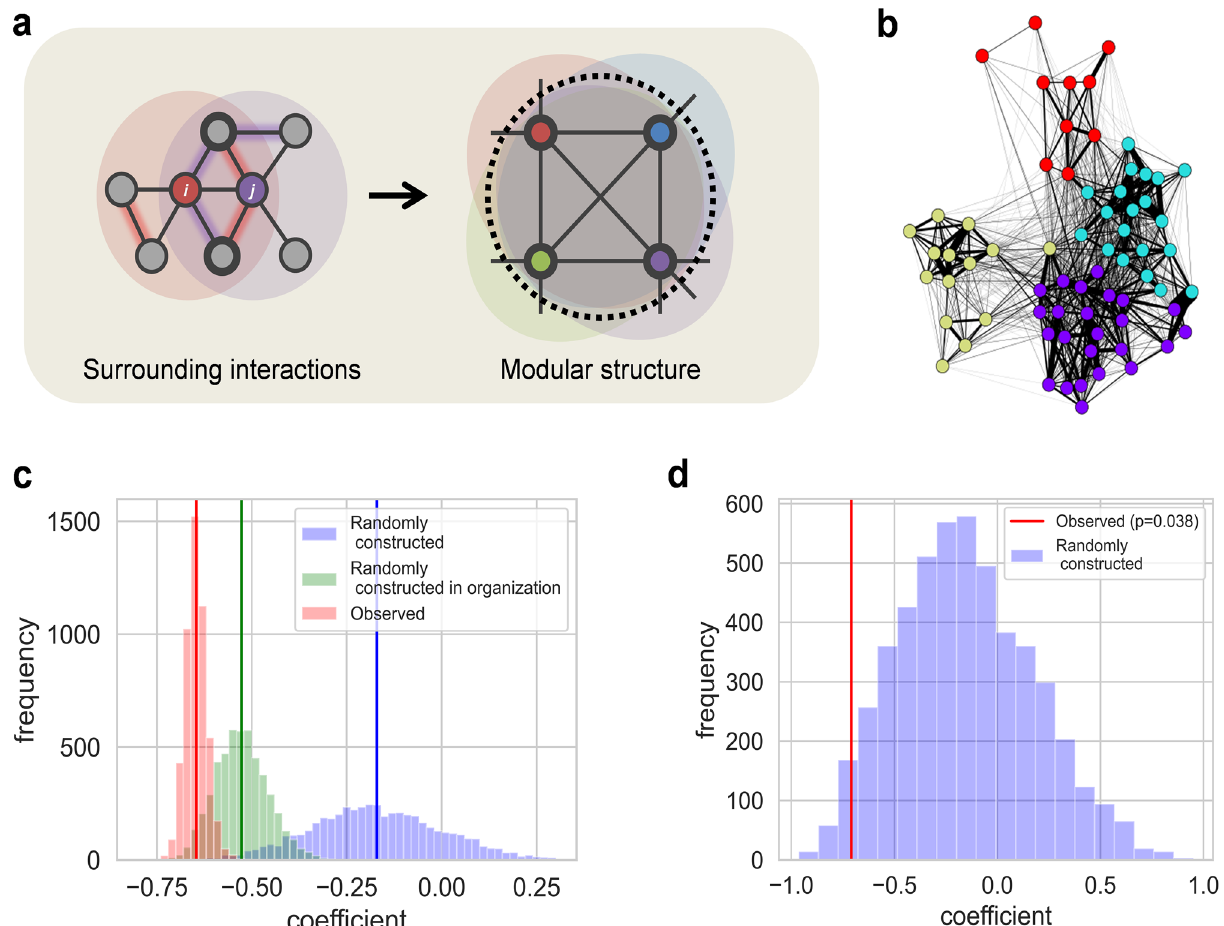
Figure 3. Modular group structure of the face-to-face interaction network and the relationship between Clustering w(B) and depression score in the group unit. ( a ) (Left) Surrounding interaction overlaps by the number of neighbours (bold lines) shared with neighbouring nodes. (Right) In a modular network structure, since each node’s surroundings overlap at a high rate within the structure, this structural unit significantly influences the clustering of the nodes belonging to it. ( b ) A representative visualization of the face-to-face interaction network of one workplace. The width of the link indicates the frequency of interaction, and the colour of the node indicates the community constructed by the community detection algorithm. Modular community structures are observed where frequent interactions occur internally. ( c ) The distributions of the Spearman correlation coefficient between the average Clustering w(B) and the average depression score of each community are shown. Each distribution represents the correlation coefficient of the community structures observed by the community detection algorithm (Red), randomly constructed (Blue), and randomly constructed within each organization (Green). Since the Louvain algorithm 36 used for community detection led to some variation in the results depending on the order of randomization in the extraction process, the coefficients in the observed community are also represented as a distribution. Each distribution was constructed through 5000 random sampling results. ( d ) The Spearman correlation coefficients between the average Clustering w(B) and the average depression score of each organization (Red) and each randomly constructed organization (Blue; 5000 random sampling) are